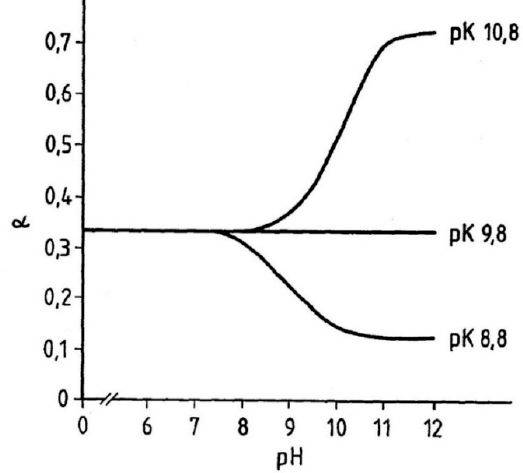
Figure 27. Reaction of hair with mercaptans of different pK values, adapted from Wolfram et al. [20], with permission from SAGE Publications, 1966.